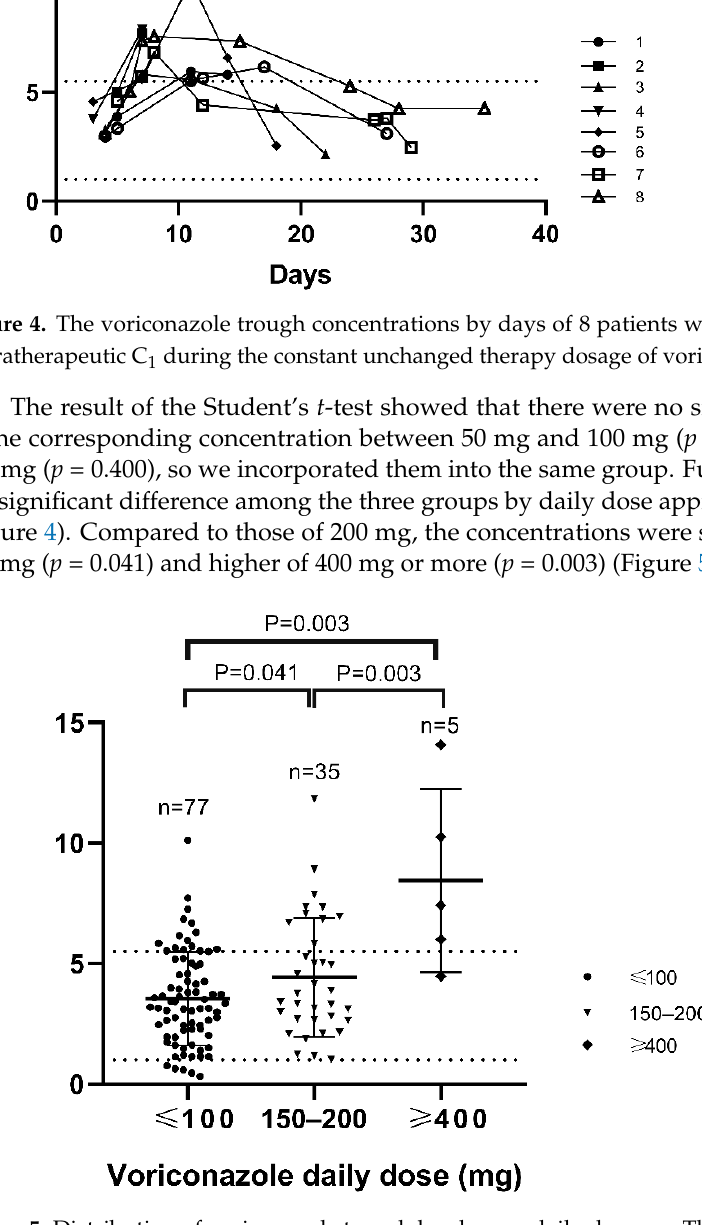
Figure 3. For 12 patients started beyond the therapeutic target ( a ) Distinction of voriconazole trough concentration in different CYP2C19 phenotype groups ( n = 50, p = 0.021). The Kruskal–Wallis test was used to compare C min s. ( b ) Distinction of voriconazole trough concentration in different groups of C 0 , C 1 , C ss ( n = 50), and daily dose ( n = 27). Data are expressed